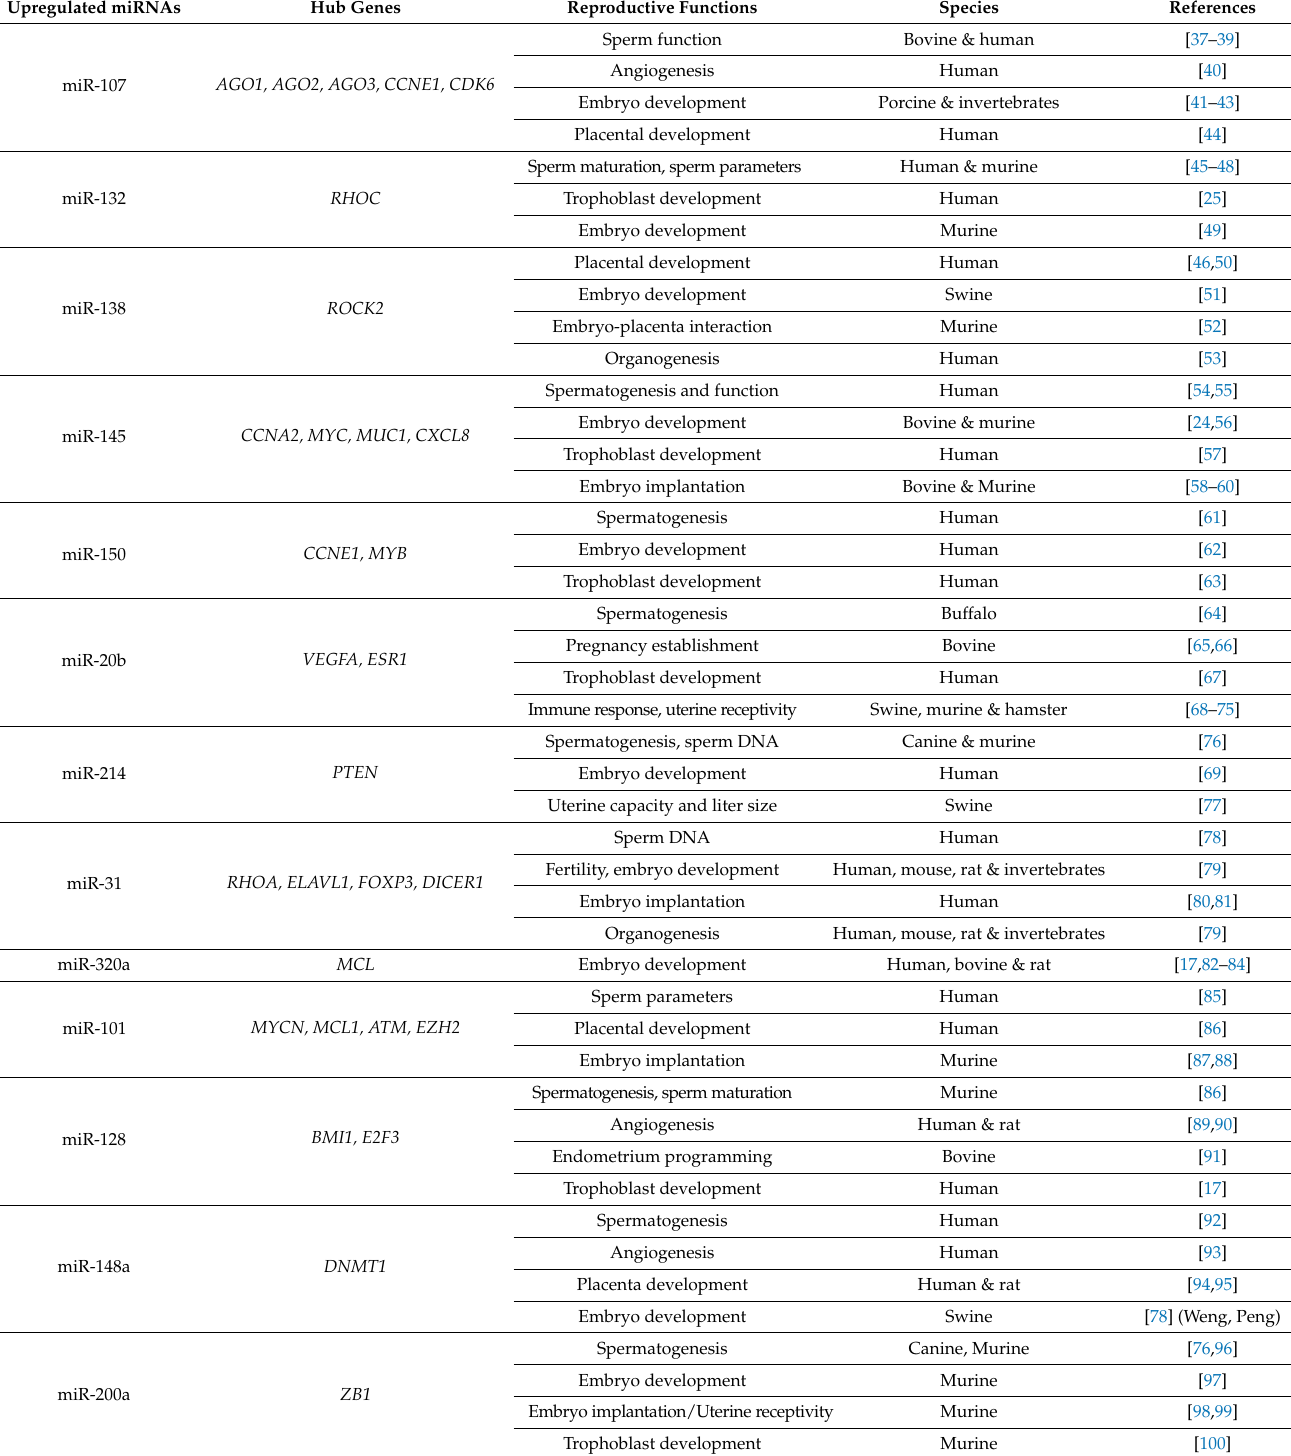
Table 3. Differentially expressed miRNAs, associated predicted hub genes and their linked reproductive